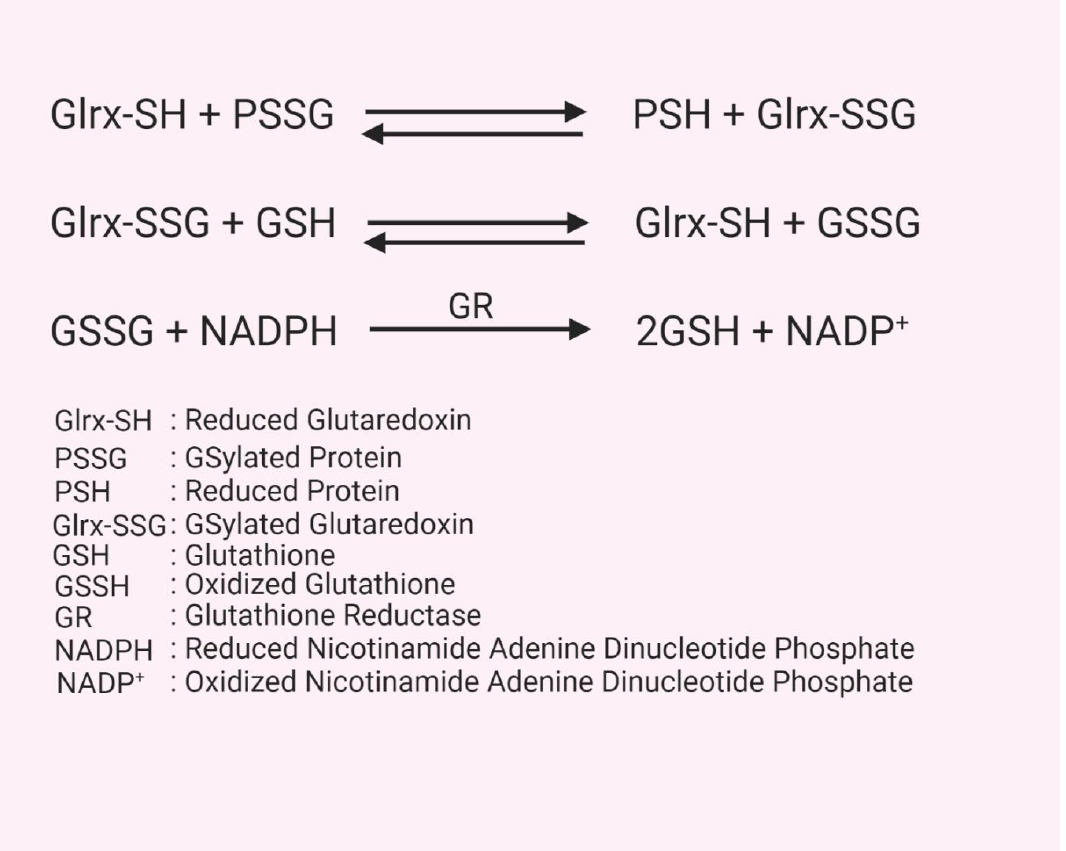
Figure 1. Glutaredoxin reaction. Figure represents steps of protein deGSylation by glutaredoxin-1 (Glrx) and regeneration of Glrx by glutathione (GSH).